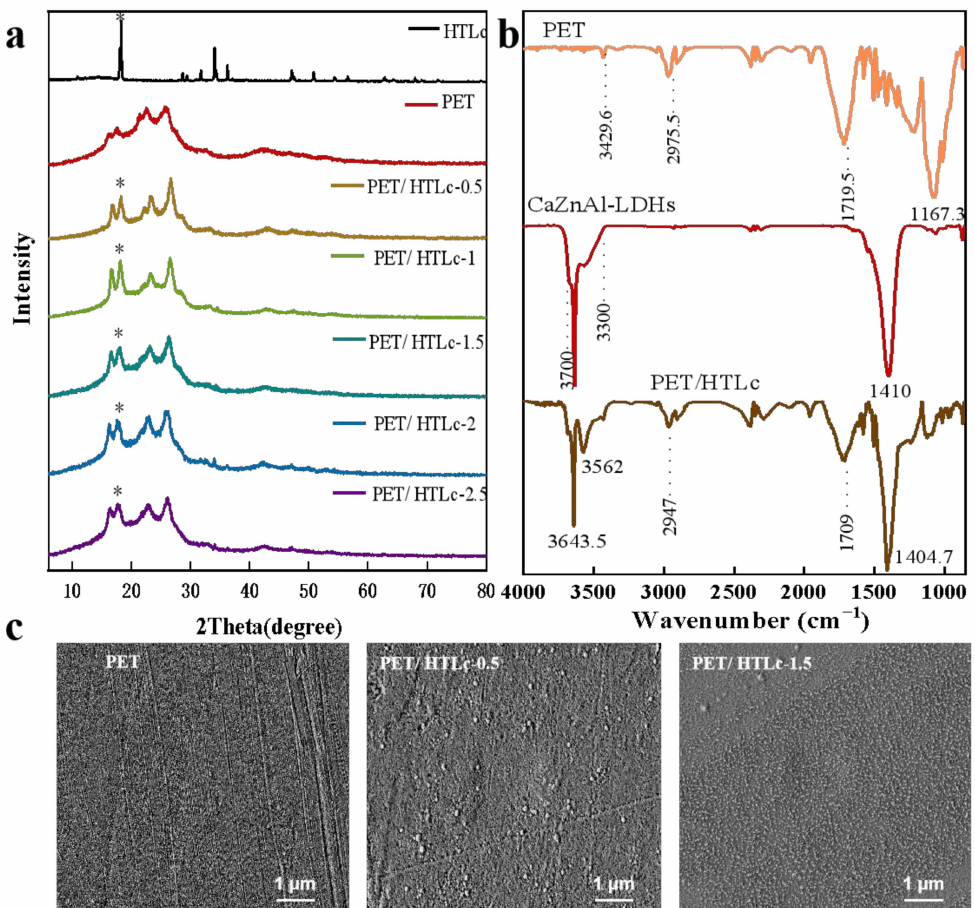
Figure 2. Morphology and structure of PET/HTLc films: ( a ) XRD patterns of a series of PET/HTLc composite films, asterisks denote the 001 reflections. ( b ) FT-IR spectra of PET, CaZnAl-LDHs and PET/HTLc film. ( c ) SEM images of PET, PET/HTLc-0.5 and